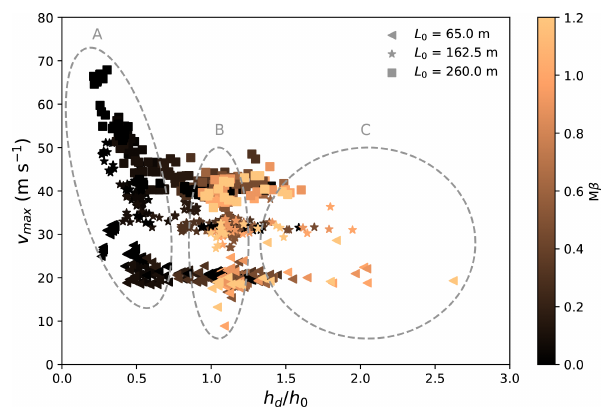
Figure 6. Evolution of the maximum velocity with the normalized deposit height for different horizontal lengths L 0 .